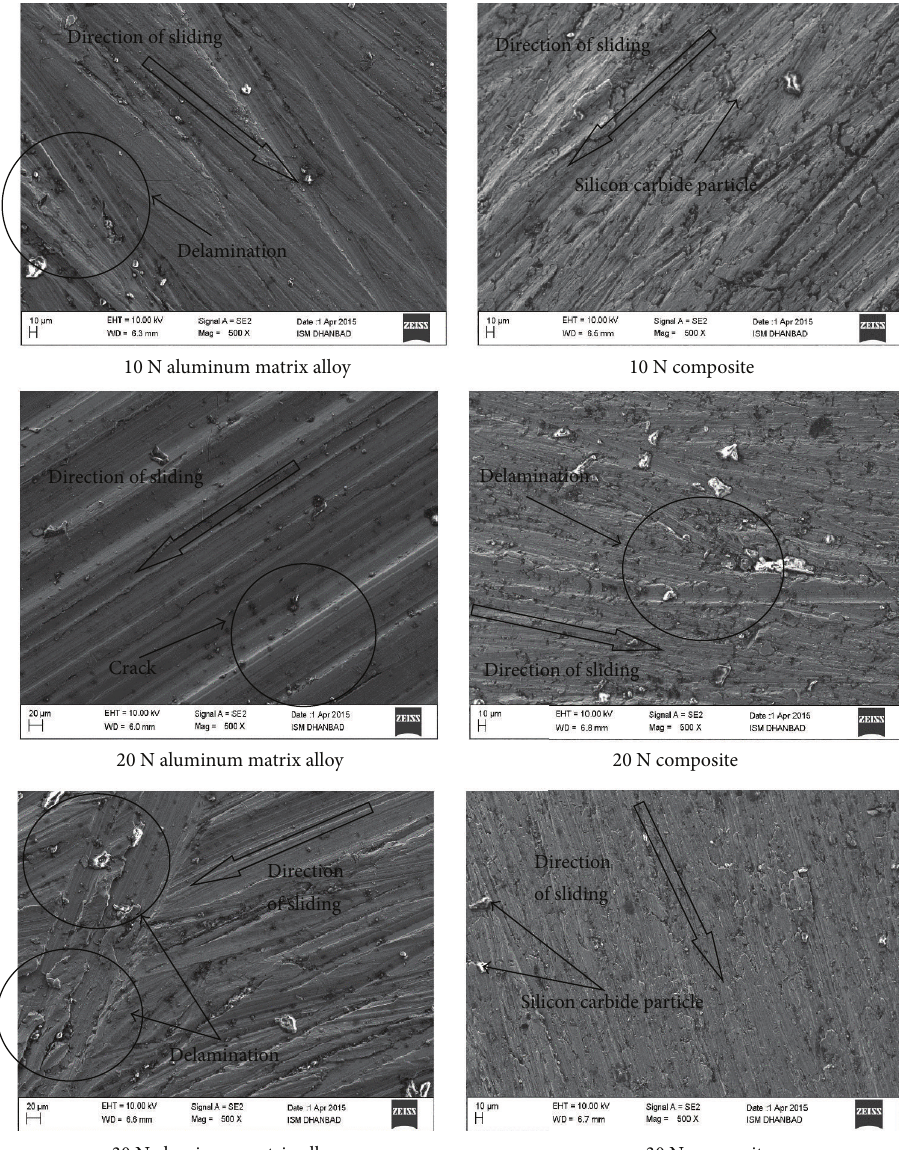
Figure 9: FESEM of worn surfaces at different loads with sliding speeds 3.77 m/s under lubricated